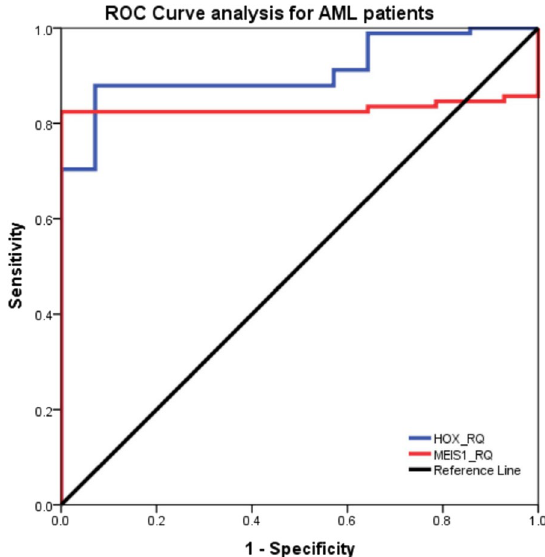
Fig. 1 ROC analysis of HOXA9 and MEIS1 gene expression for discriminating adult AML patients